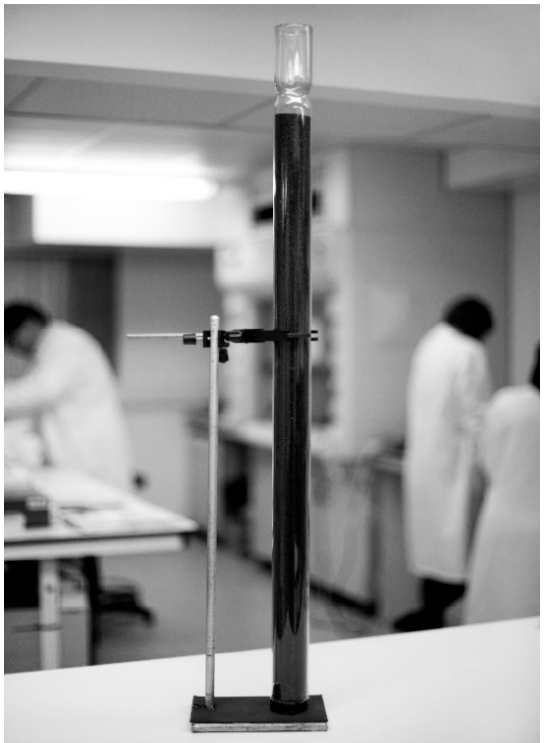
Figure 5. The original glass column filled with charcoal used to prepare phenylalanine-free casein hydrolysate for Sheila’s diet.